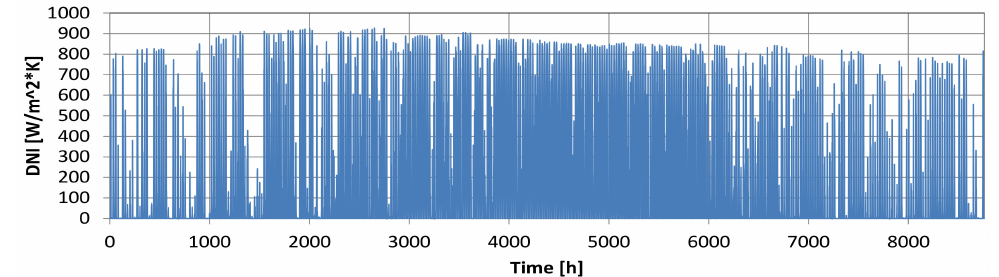
Figure 17. Annual DNI time-series measured at ENEA Casaccia